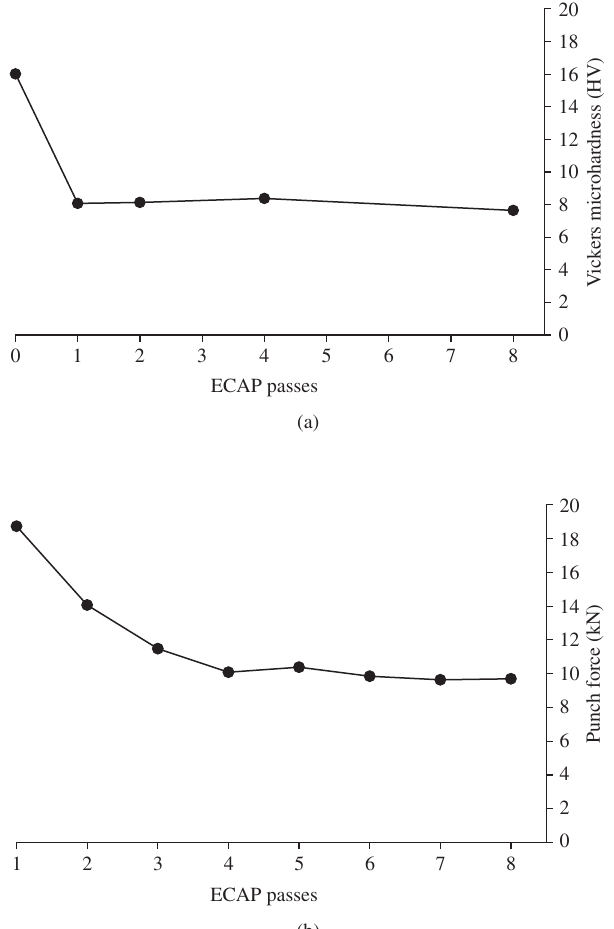
Figure 11. a) Microhardness; and b) Punch force evolution with the number of ECAP passes.